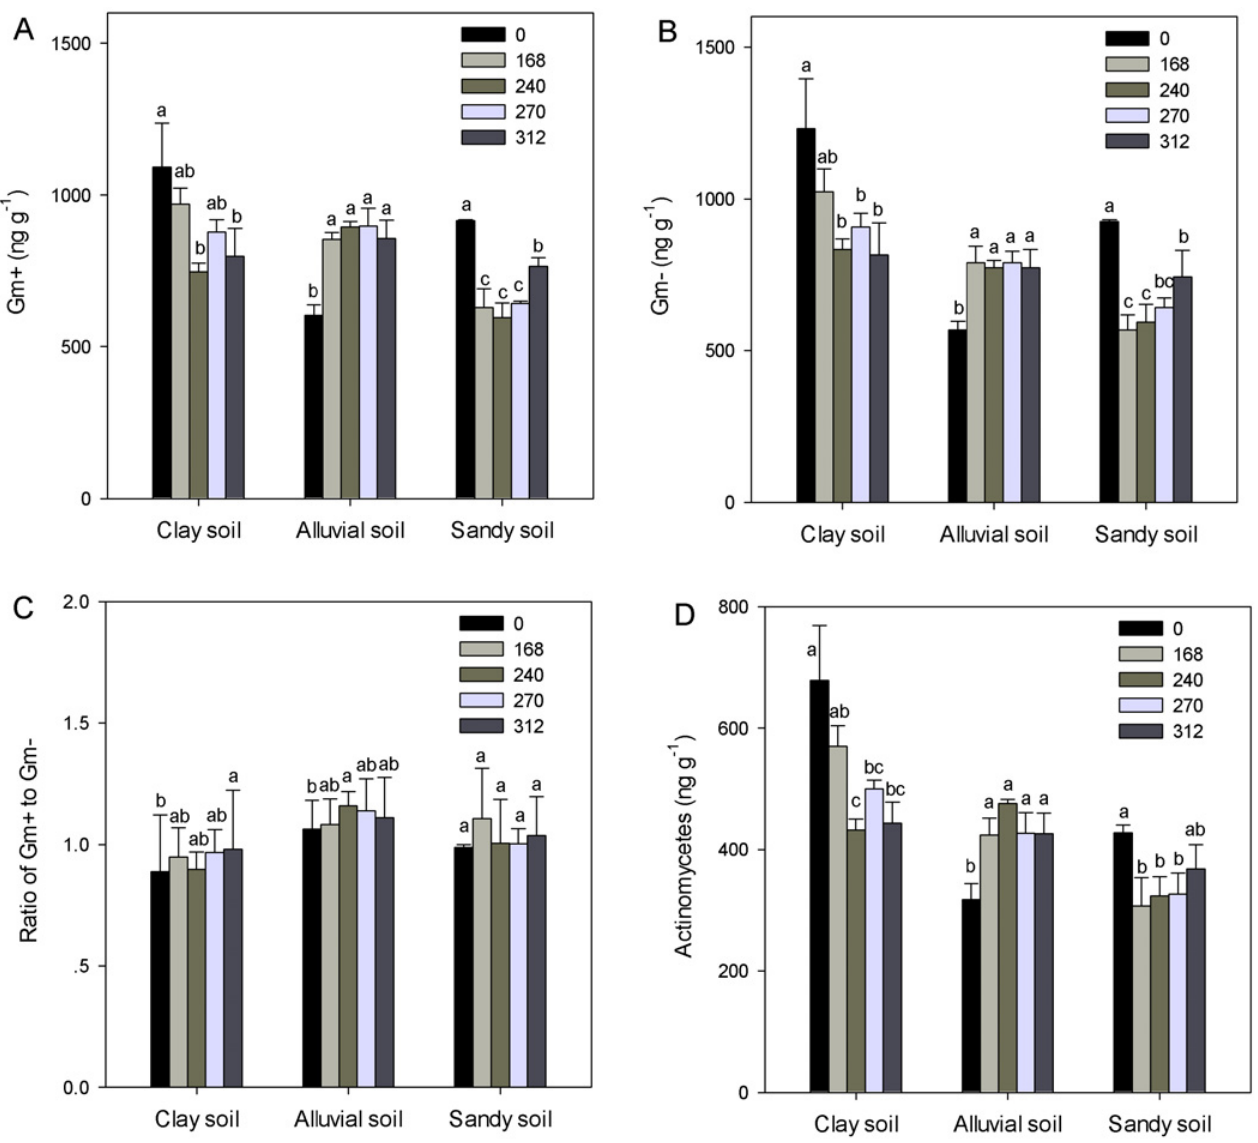
Fig 2. Concentrations of gram-positive (Gm+, A) and gram-negative bacteria (Gm – , B), ratios of Gm+ to Gm- (C), and concentrations of actinomycetes (D) in three soils under application of N fertilizers at five rates (0, 168, 240, 270 and 312 kg N ha -1 ). Error bars indicate standard errors. Different letters within each soil indicate significant differences among N fertilization